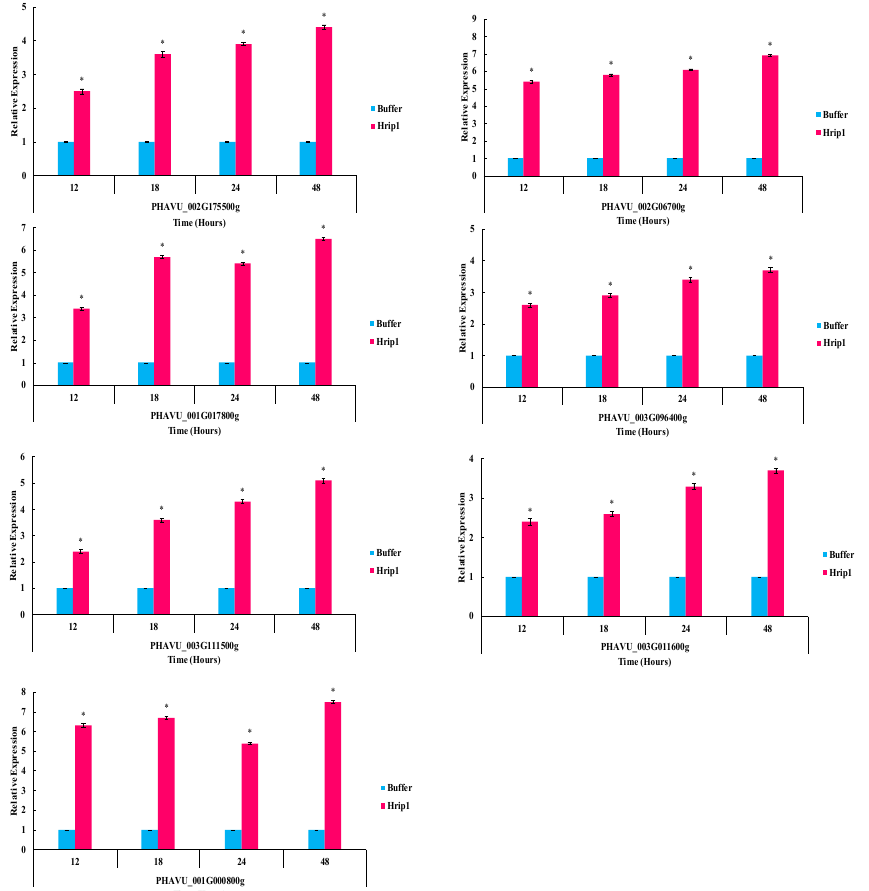
Figure 7. After Hrip1 elicitor treatment and aphid infestation, the relative expression of plant defense from the JA pathway was detected. An asterisk next to each gene indicates a significant difference from the buffer control, as determined using Student’s t -test ( p < 0.05).